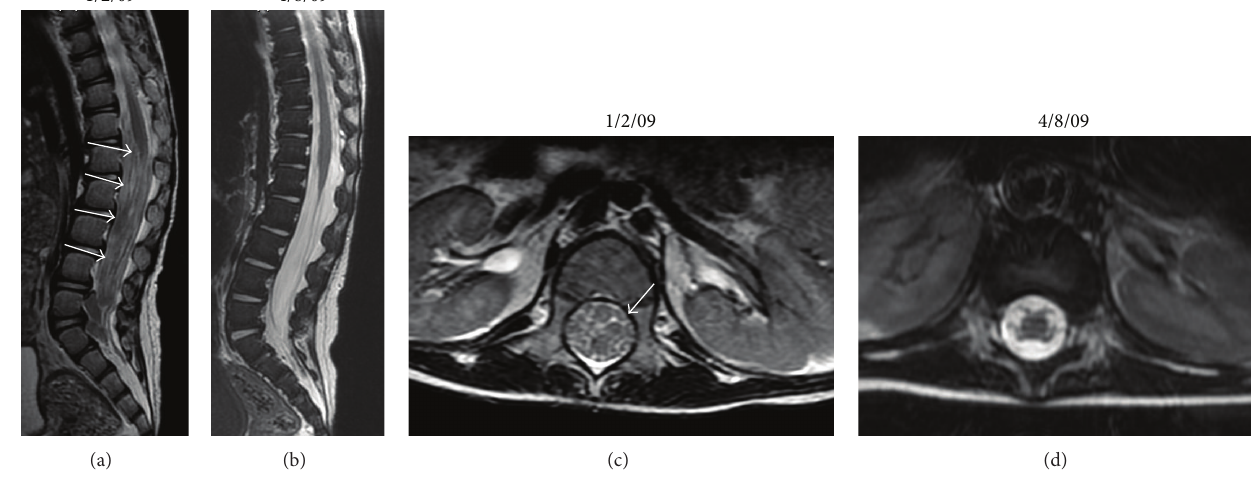
Figure 3: (a) 1/2/09 MRI spine T2 weighted image shows extensive abnormal and nodular enhancement filling the thecal sac from T11-12 extending down through the lumbosacral spine (arrows). (b) 4/8/09 MRI spine T2 weighted image shows near resolution of previously seen abnormal enhancement. (c) 1/2/09 MRI spine axial image demonstrates enhancing masses and thickened nerve roots filling the thecal sac at L1. (d) 4/8/09 MRI spine axial image with normal appearance of thecal sac and nerve roots at